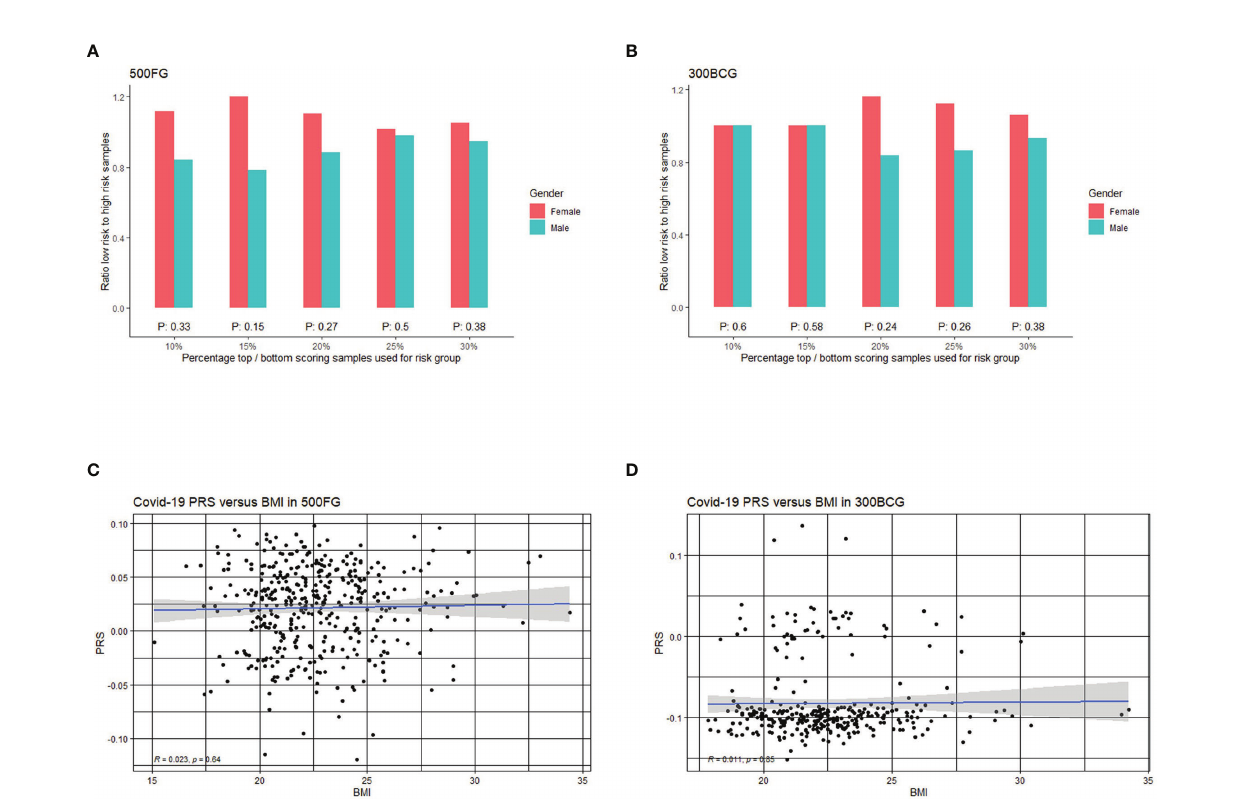
FIGURE 4 | Correlation of COVID-19 PRS with sex and BMI. (A) Bar plot representing the ratio of low versus high PRS based risk between men and women in 500FG calculated without including the sex chromosomes. The X-axis shows the range of different quantiles (e.g.,10% corresponds to those individuals with PRS between 0 th and 10 th percentile of the population), and the Y-axis shows the odds ratio when comparing low PRS risk and high PRS risk in the male and female group from different quantiles. (B) Bar plot representing the ratio of low versus high PRS based risk between men and women in 300BCG calculated without including the sex chromosomes. (C) Scatter plot showing the correlation between PRS with BMI in 500FG. (D) Scatter plot showing the correlation between PRS with BMI in